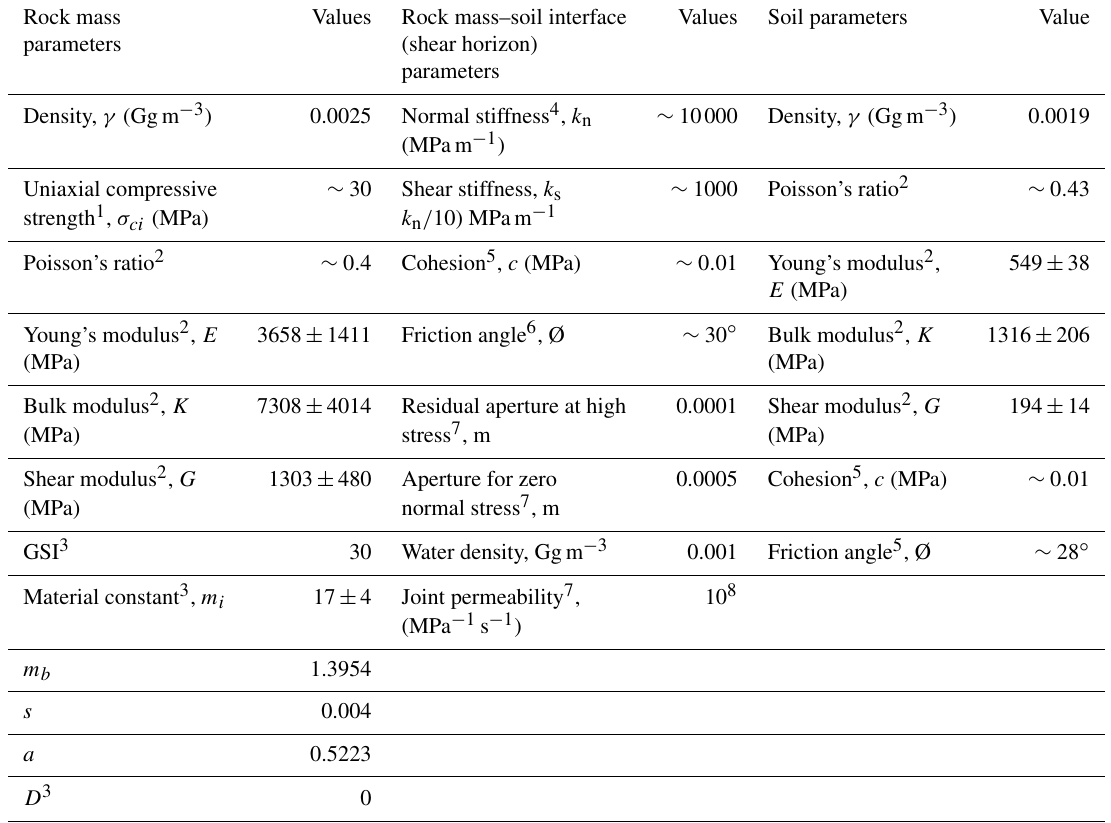
Table 1. Input parameters used in the slope stability analysis.